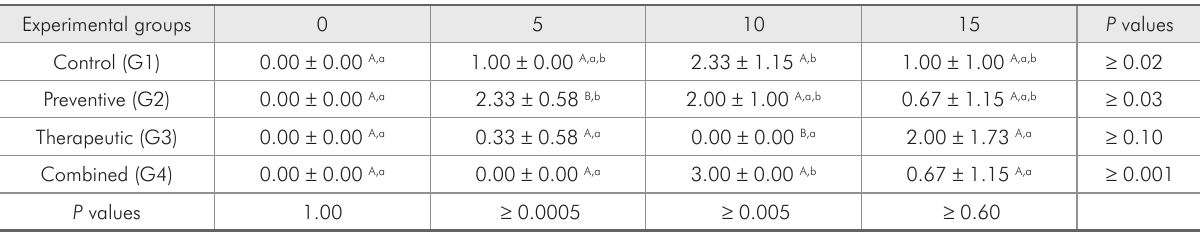
Table 2 - Mean ± standard deviation of clinical scores of animals in different groups at different evaluation times (days). Experimental